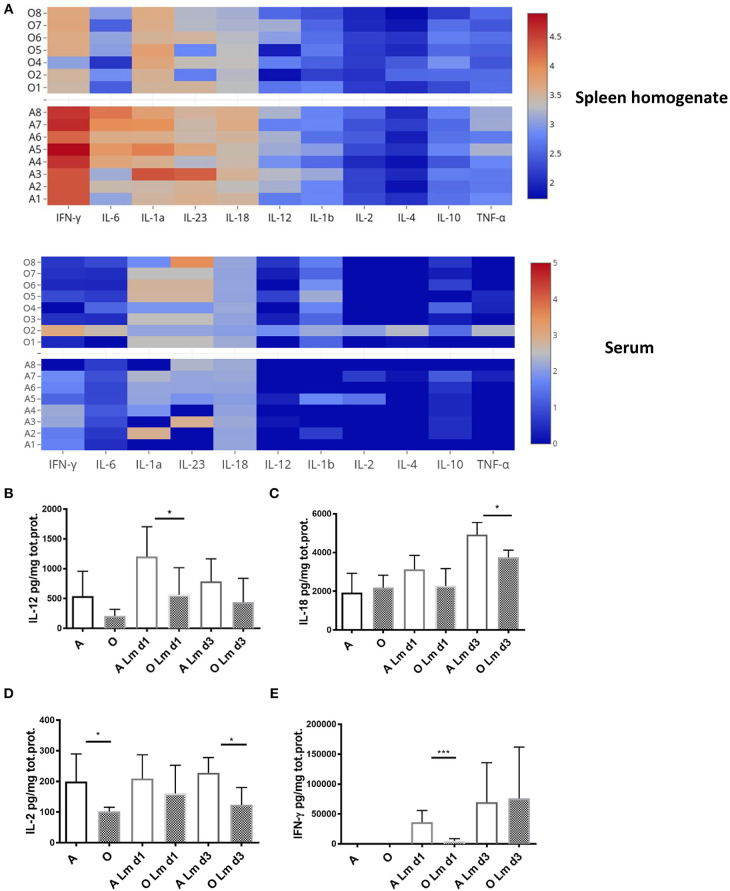
Old mice exhibit lower levels of multiple inflammatory cytokines early after infection with Listeria monocytogenes. Expression of multiple inflammatory cytokines was measured in spleen homogenates and serum of Listeria infected (104 CFU i.v.) adult and old C57/BL6 mice (N = 8) on days 1 and 3 p.i. by Legendplex immunoassay. Spleens were homogenized in phosphate buffered saline containing protease inhibitor cocktail and 0.5% NP-40 detergent. (A) Heat map shows that the expression of all cytokines per mg total protein on day 1 p.i. was higher in spleen homogenate than serum while there was a decrease in multiple cytokines in spleen homogenates of old mice. (B) IL-12 was significantly decreased in old spleen homogenate on day 1 p.i. (C) IL-18 was significantly decreased in old spleen homogenate on day 3 p.i. (D) IL-2 was significantly decreased in old spleen homogenate of naïve mice and on day 3 p.i. (E) IFN-γ was drastically reduced in old mice on day 1 p.i. (*p < 0.05, **p < 0.01, ***p < 0.001, ****p < 0.0001).